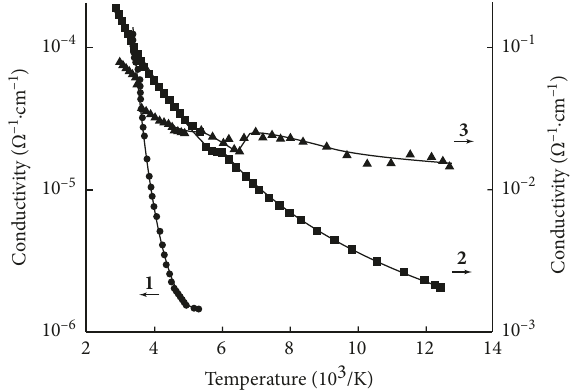
Figure 4: Temperature dependences of DC electrical conductivity for TlFe 1 − x Ga x S 2 : x � 0 ( 1 ), 0.025 ( 2 ), and 0.1 ( 3